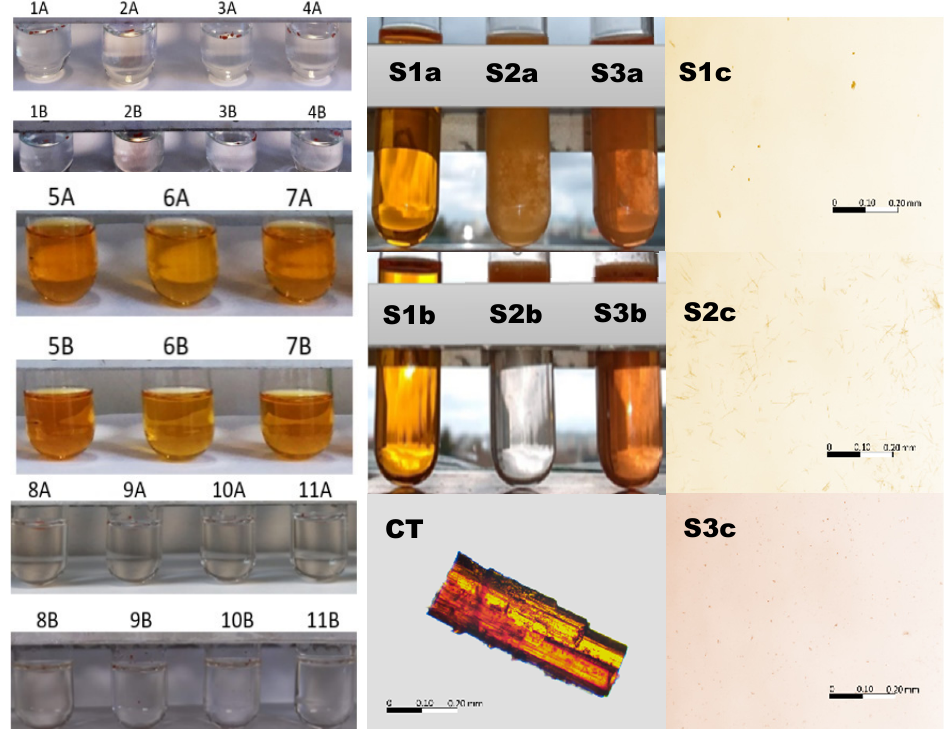
Figure 3. Left panel: macroscopic illustration of CT in various solvents and color intensity on the first ( A ) and eighth days ( B ) after dissolution in the solvents: distilled water ( 1 ), 0.1 mol/L sodium hydroxide ( 2 ), 1.0 mol/L sulfuric acid (VI) ( 3 ), 0.5087 mol/L hydrochloric acid ( 4 ), methanol ( 5 ), ethanol ( 6 ), isopropanol ( 7 ), AMPD ( 8 ), TRIS ( 9 ), TEOA ( 10 ), and TIPA ( 11 ). Middle panel: macroscopic illustration of CT in 96% ethanol ( S1 ), 8% ethanol ( S2 ), and 8% ethanol with a 0.1 mol/L solution of NaOH ( S3 ). Illustration of the influence of ethanol on the solubility of CT in the 0.1 mol/L solution of NaOH immediately ( a ) and after 5 min ( b ), and a microscope image of the powdered CT particle in the air. Right panel : microscope images of a drop taken from the surface of the samples in the test tubes S1b, S2b and S3b, respectively. The bar represents the same longitude (200 µ m). The details are in the text.